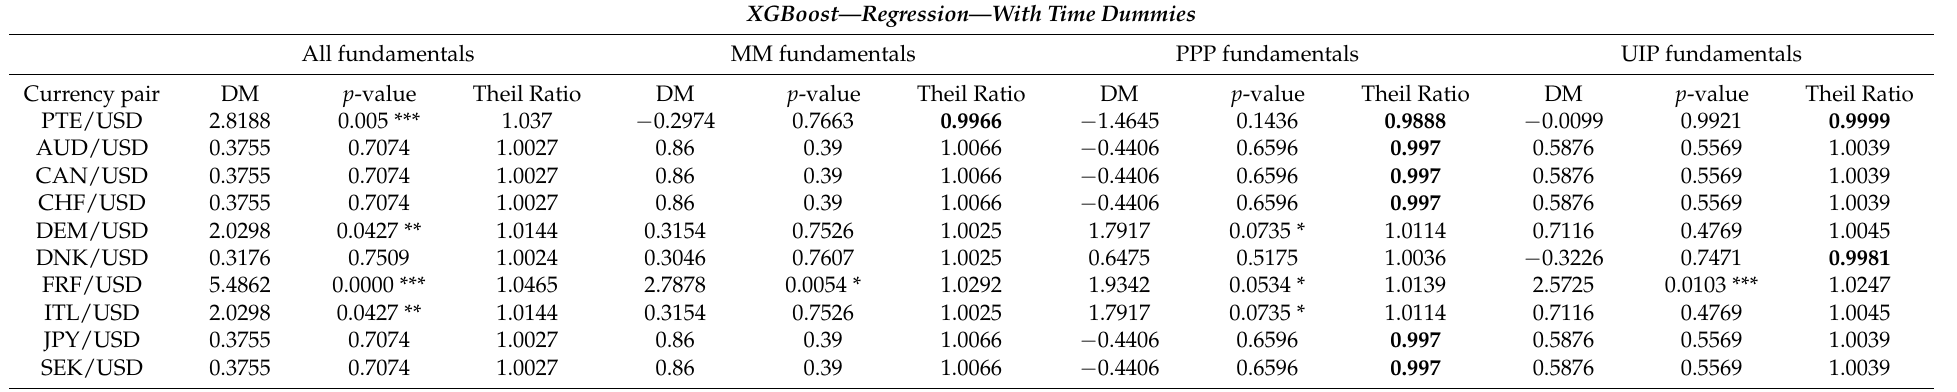
Table 1. One-month-ahead forecasting of exchange rate differentials with fundamentals using XGBoost. XGBoost—Regression—With Time